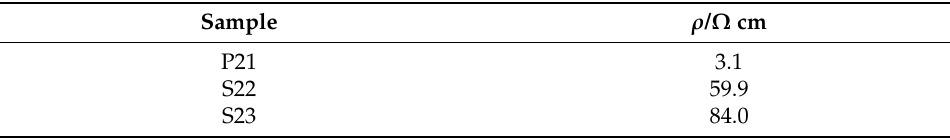
Table 4. Electrical resistivity ( ρ ) of the activated